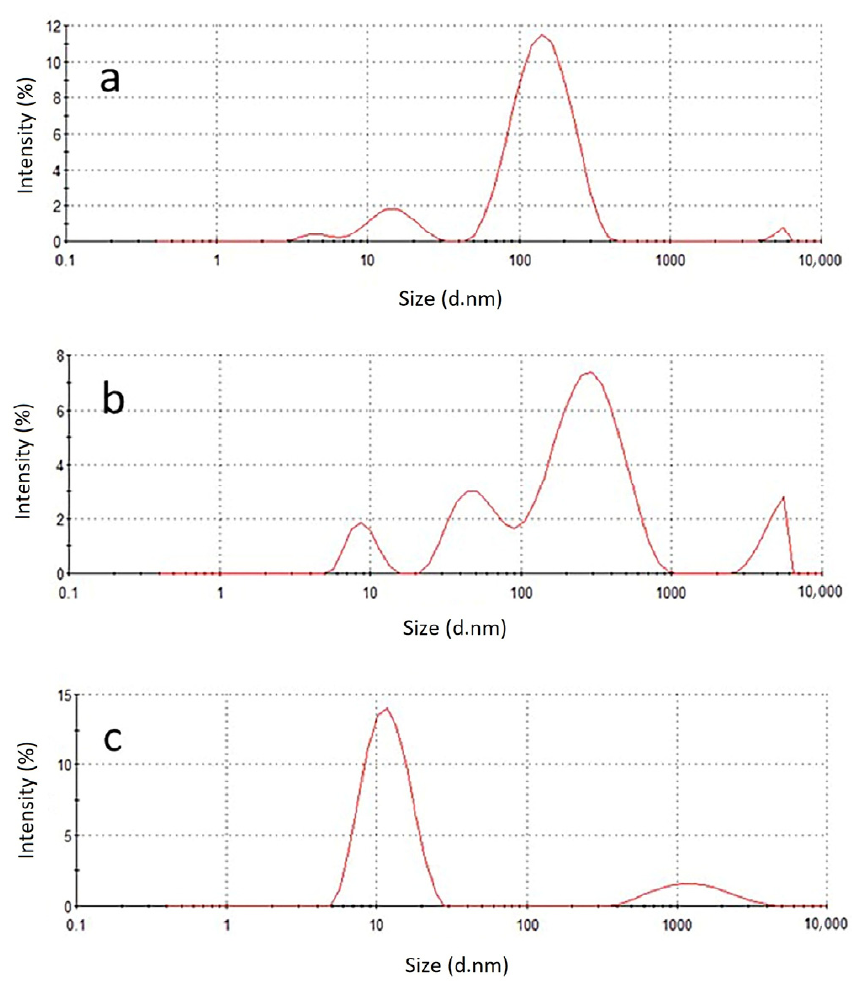
Figure 3. Size distribution spectrum of ( a ) exosome sample before lysis, ( b ) exosome sample after lysis, and ( c ) 0.1% Triton X-100.